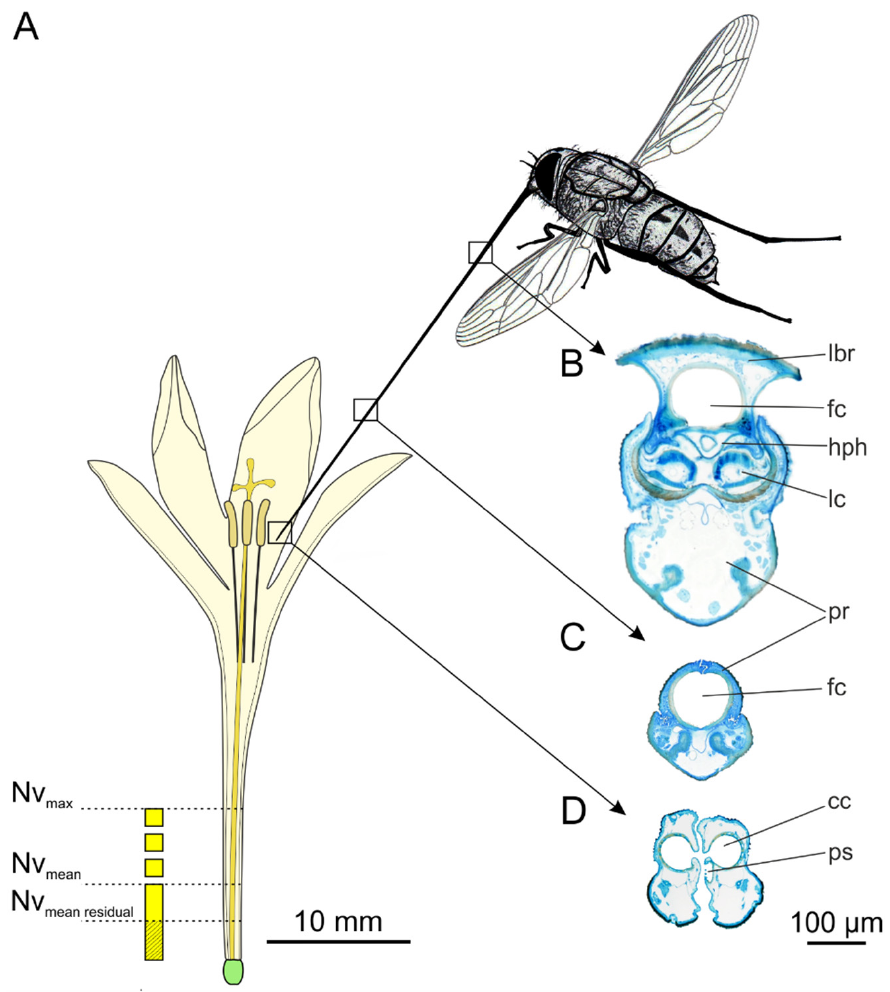
Figure 3. Nectar accessibility for P. marinusi from ( A ) an average B. vanzijliae flower. Nectar heights calculated using the GeoGebra tool (https://www.geogebra.org/m/se2cwx9s, accessed on 16 April 2021) from measured quantities, modelled with a mean inner diameter and average tube length ( n = 41). Maximal nectar volume (N vmax ) resulted in nectar height approximately up to half length. Mean nectar volume before fly activity (N vmean , n = 44) fills nectar tube up to 20% of tube length. Mean residual nectar volume after fly visited (N vresidual , n = 39) in the proximal was 10%. ( B ) Cross section of the proximal proboscis. ( C ) Proboscis cross section of distal proboscis that is composed only by the prementum. ( D ) Cross section of the labella at the tip of the proboscis. cc: collecting canal; fc: food canal; hph: hypopharynx; lbr: labrum; lc: lacinia; pr: prementum; ps: pseudo-trachea.